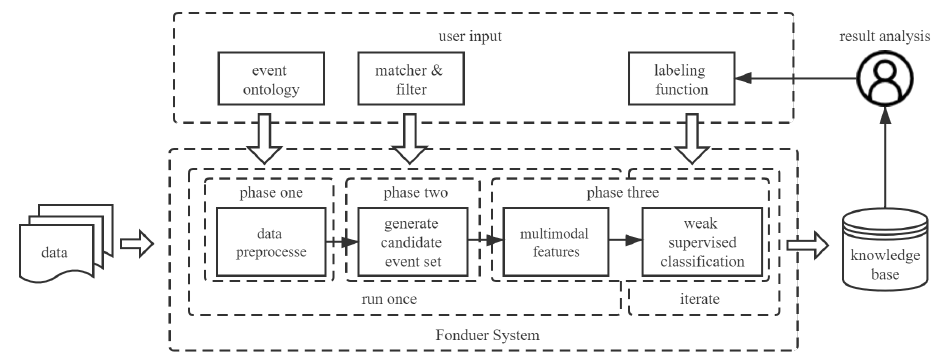
Figure 3. The process of knowledge base